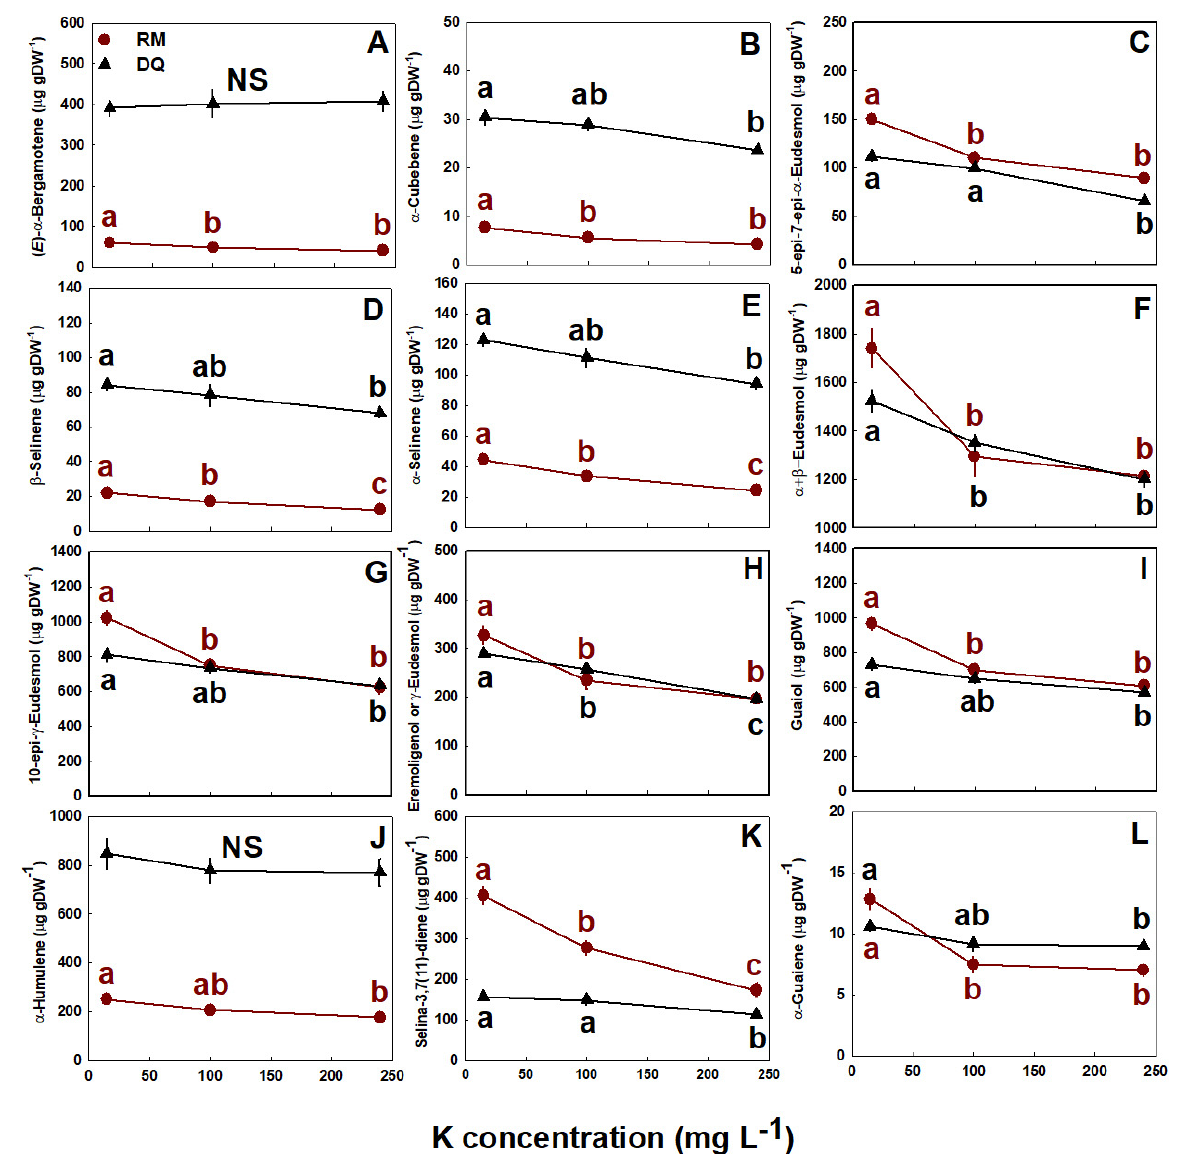
Figure 6. Effect of K supply on sesquiterpene concentration in the medical cannabis cultivars RM and DQ. ( E )- α -Bergamotene ( A ), α -cubebene ( B ), 5-epi-7-epi- α -eudesmol ( C ), α -selinene ( D ), β -selinene ( E ), α + β -eudesmol ( F ), 10-epi- γ -eudesmol ( G ), eremoligenol or γ -eudesmol ( H ), guaiol ( I ), α -humulene ( J ), selina-3,7(11)-diene ( K ) and α -guaiene ( L ) concentration in the top (primary) inflorescence. Presented data are averages ± SE ( n = 5). Where not seen, the error bars are smaller than the symbol size. In the one-way ANOVA results, NS signifies no significant differences between treatments, and different small letters signify significant differences between treatments by Tukey’s HSD test at α = 0.05.